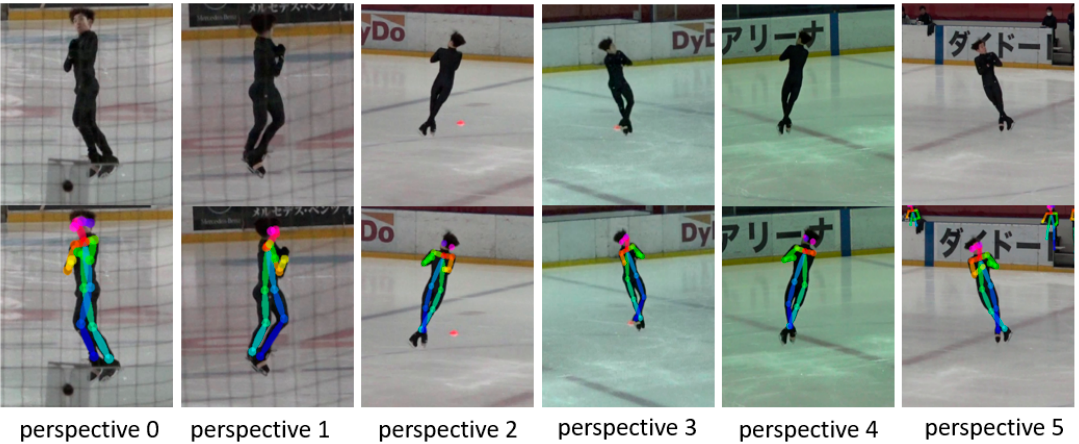
Figure 2. 2D information from